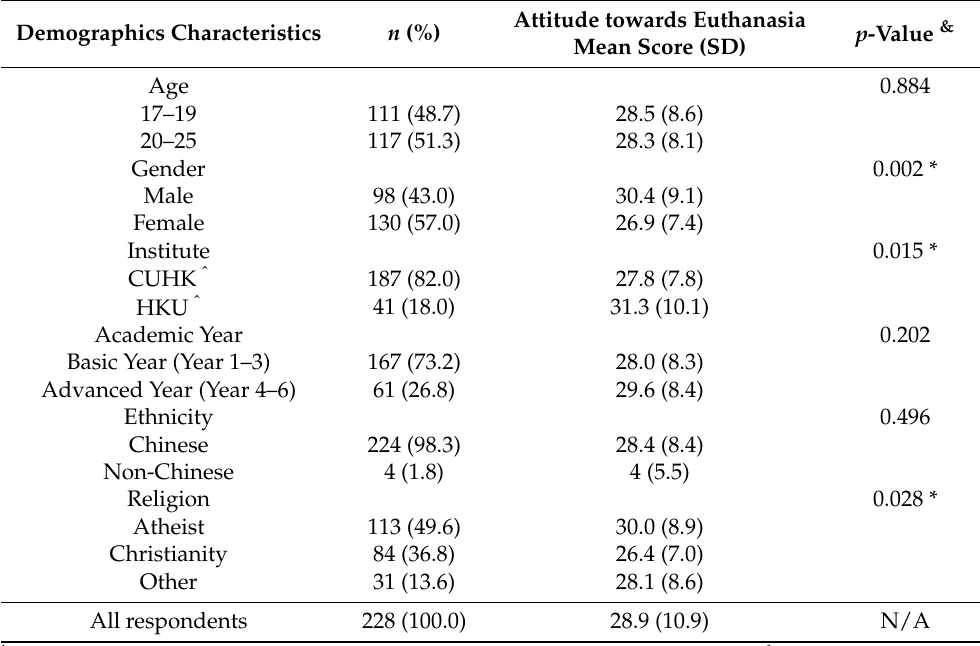
Table 1. Demographics of undergraduate medical students ( n = 228). Demographics